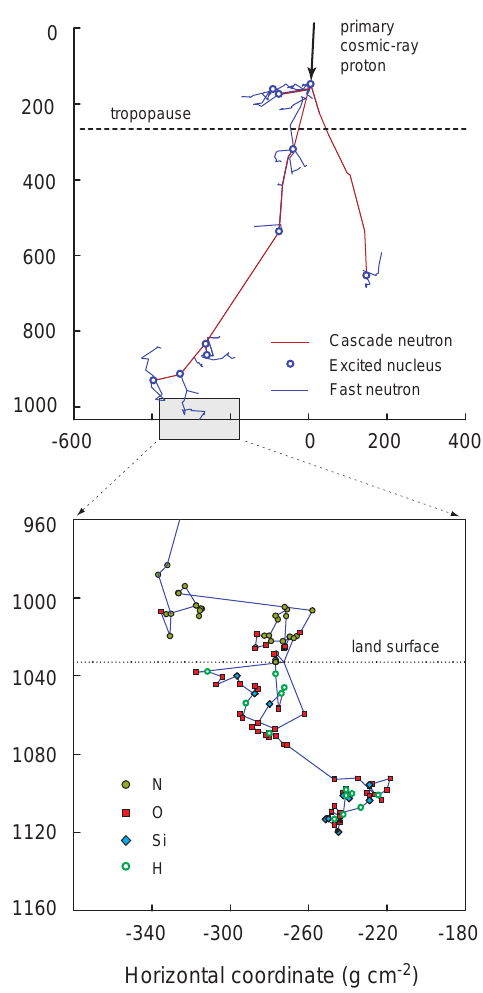
Fig. 3. Cascade of high-energy secondary neutrons, and production and scattering of fast neutrons in air and ground (modified from Fig. 1 in Desilets et al.,